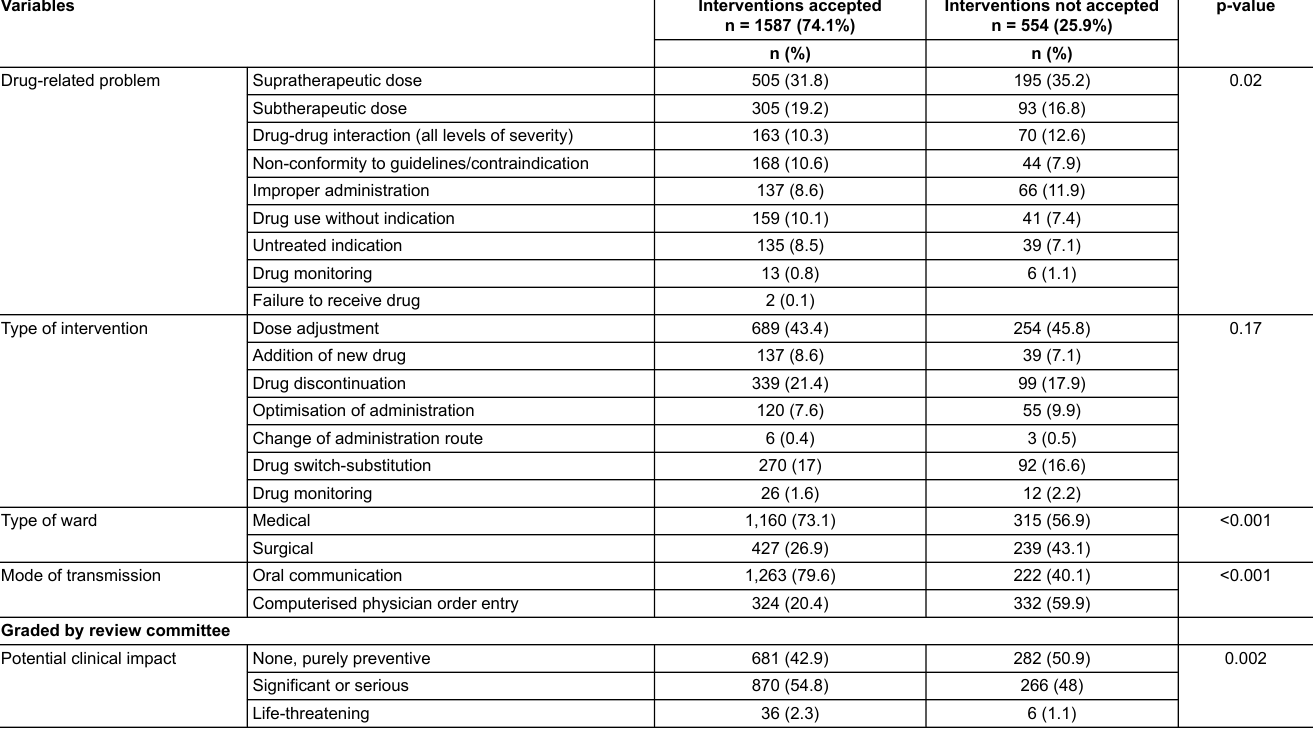
Table 2: Association between acceptance and variable.